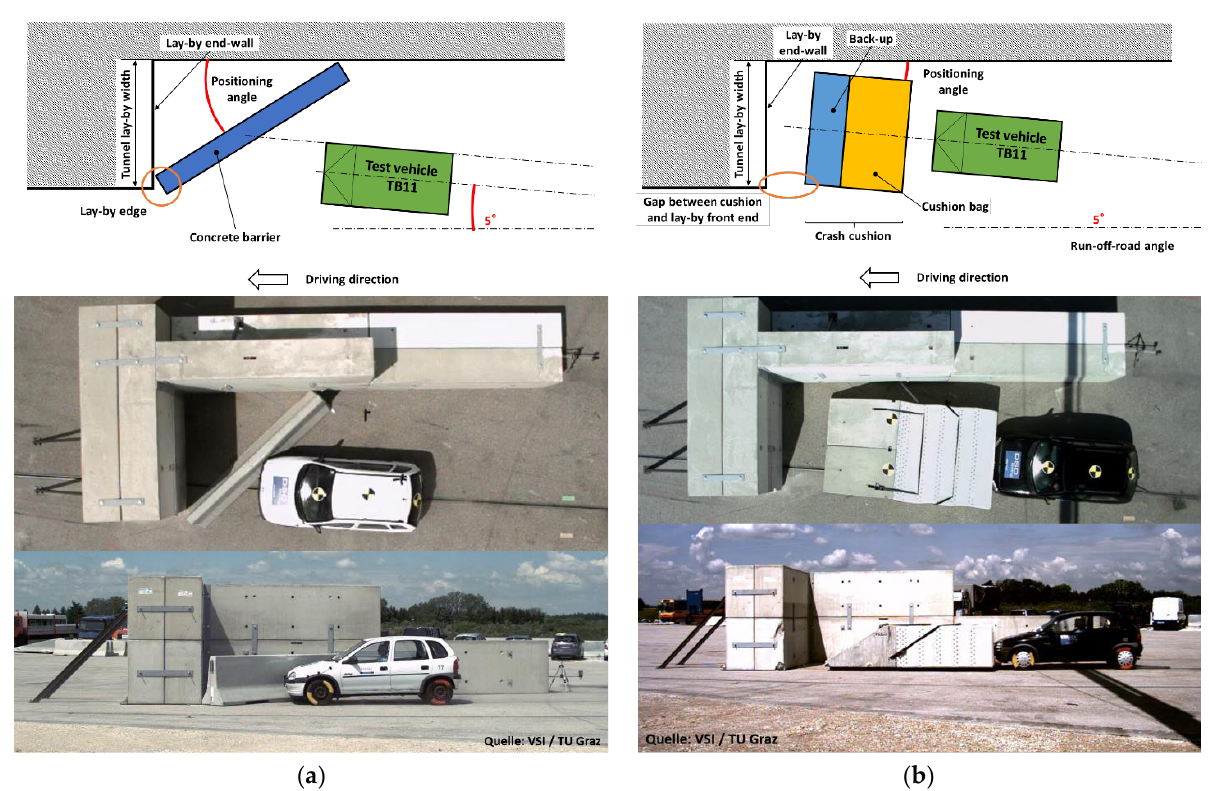
Figure 6. Test set-up for an angular positioned concrete barrier and vehicle position at first contact ( a ) and the crash cushion with the vehicle position at the first contact ( b ).